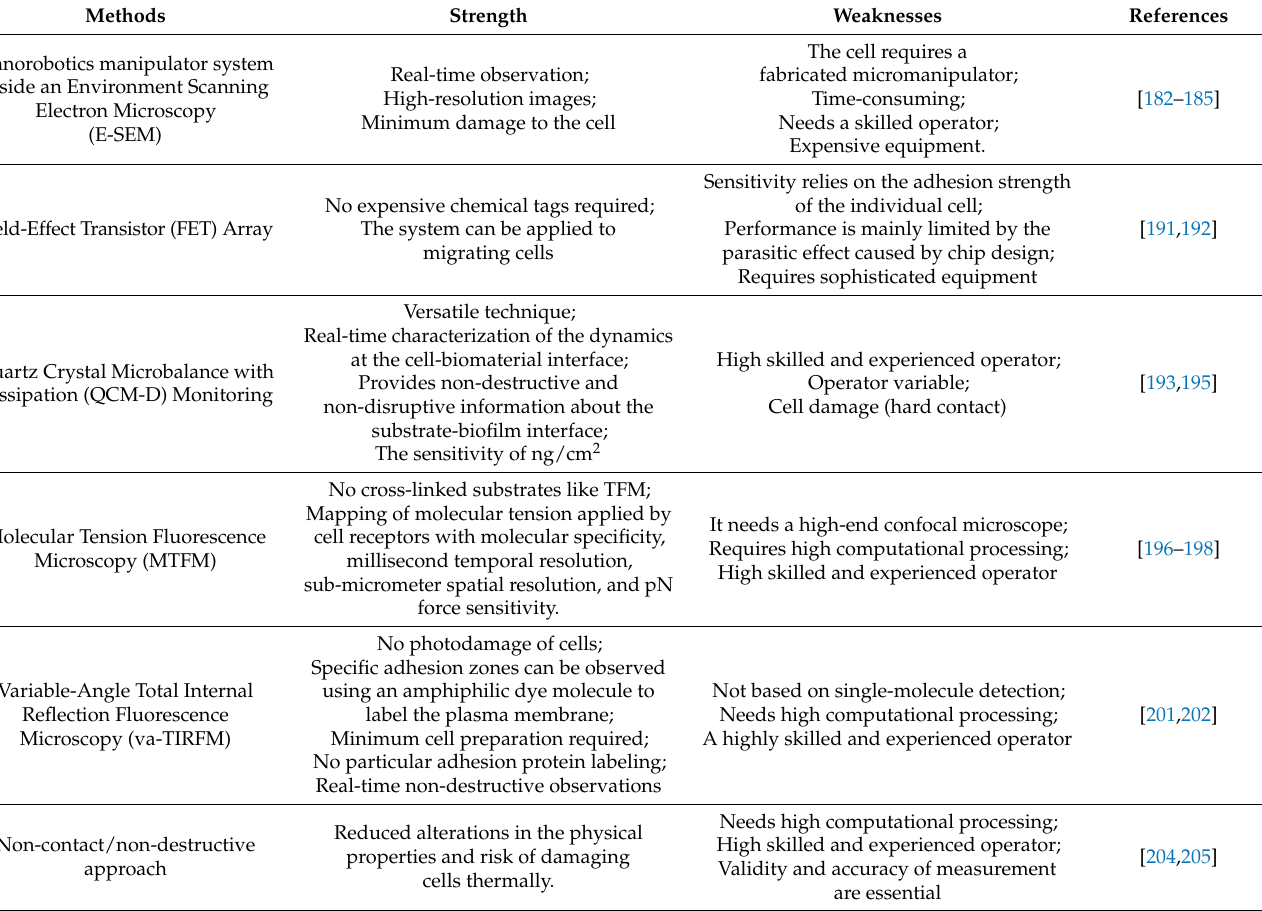
Table 2. Comparison of advantages and limitations in the recent techniques used for cell adhesion studies. Methods Strength